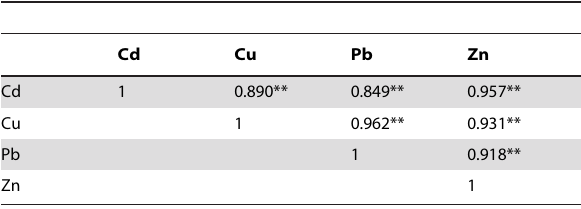
Table 9. Pearson correlation coefficients of heavy metals